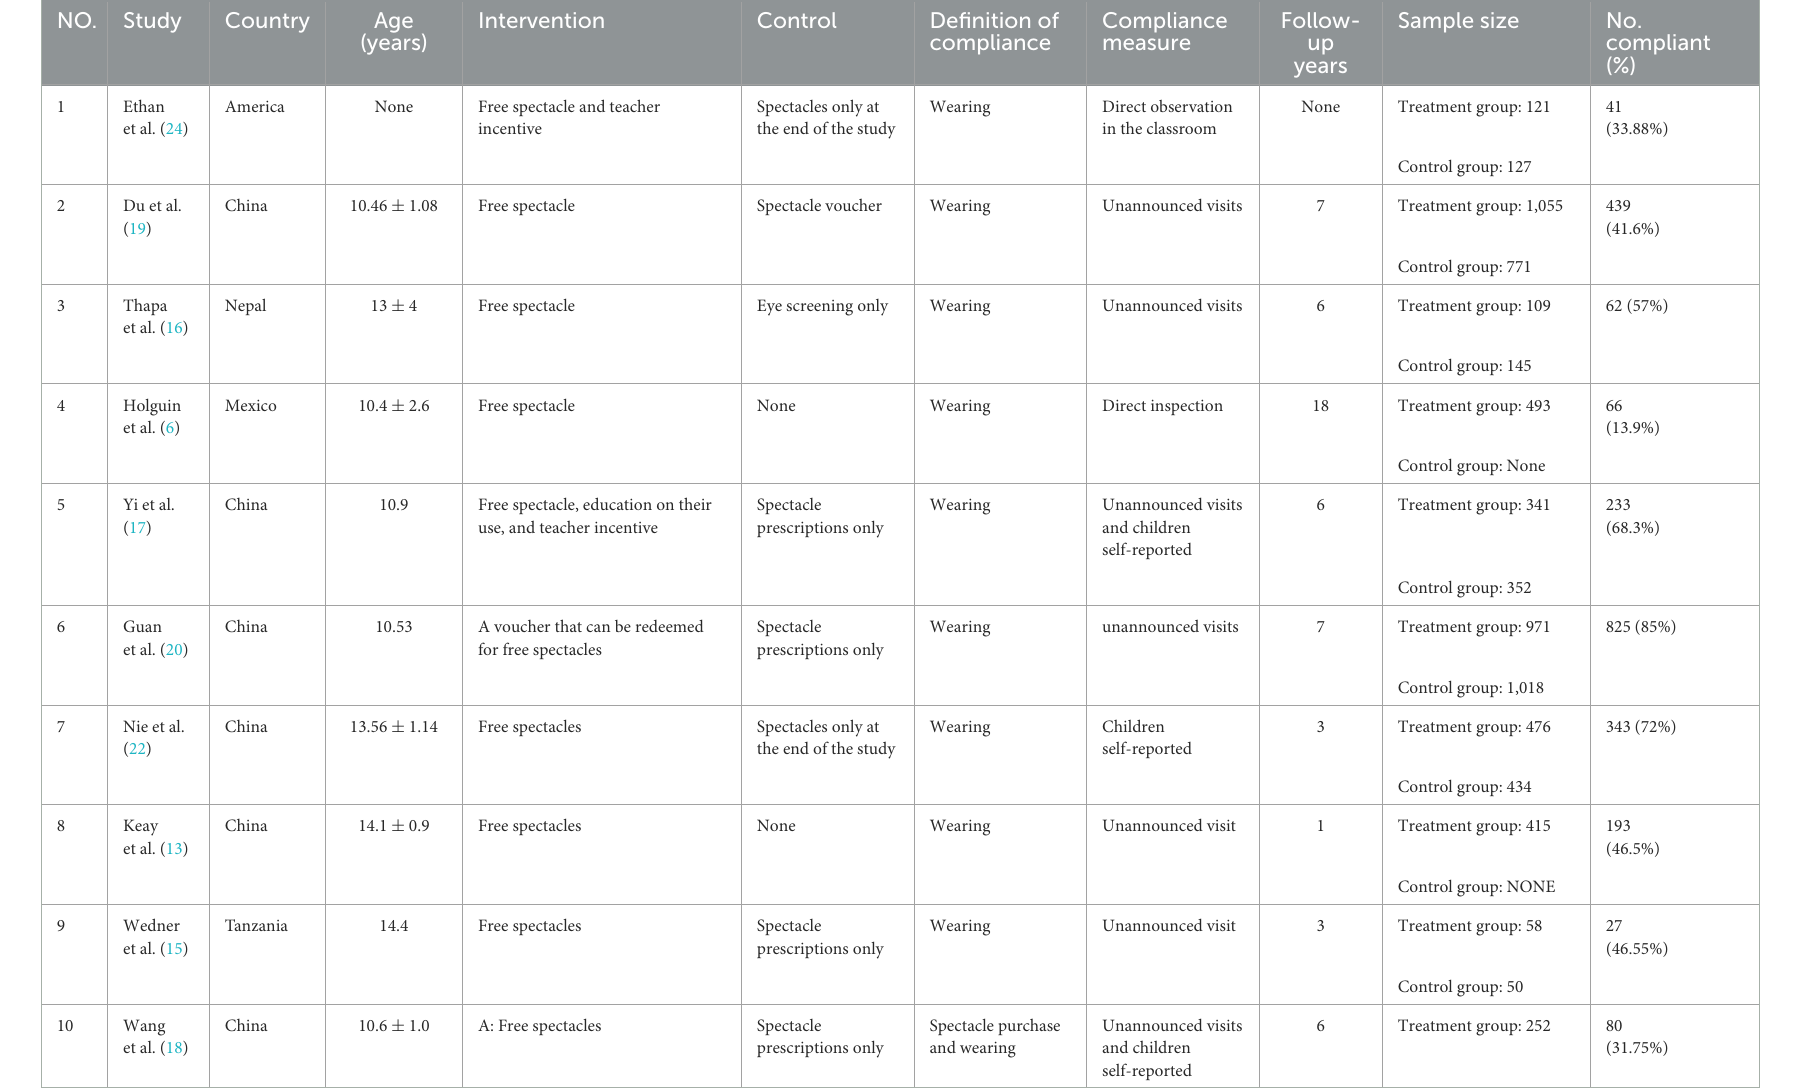
TABLE 1 Characteristics of selected studies included in the systematic review ( N = 14).